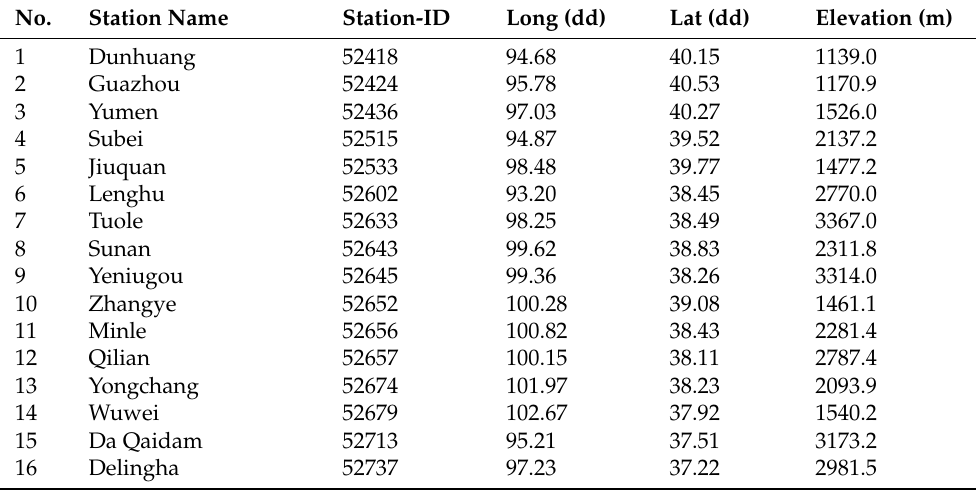
Figure A1. ( left ) The changes of extreme precipitation indices in the middle of the 21st century as compared to the base period, ( middle ) the changes of extreme precipitation indices at the end of the 21st century as compared to the base period, and ( right ) the changes of extreme precipitation indices at the end of the 21st century as compared to the middle of the 21st century. Spatial distribution over the Qilian Mountains under SSP245: ( a – c ) CDD, ( d – f ) CWD, ( g – i ) R10mm, and ( j – l ) R95p. Note that the future change is represented by the ensemble of the corrected CMIP6 models.. Table A1. Location information of the basic weather